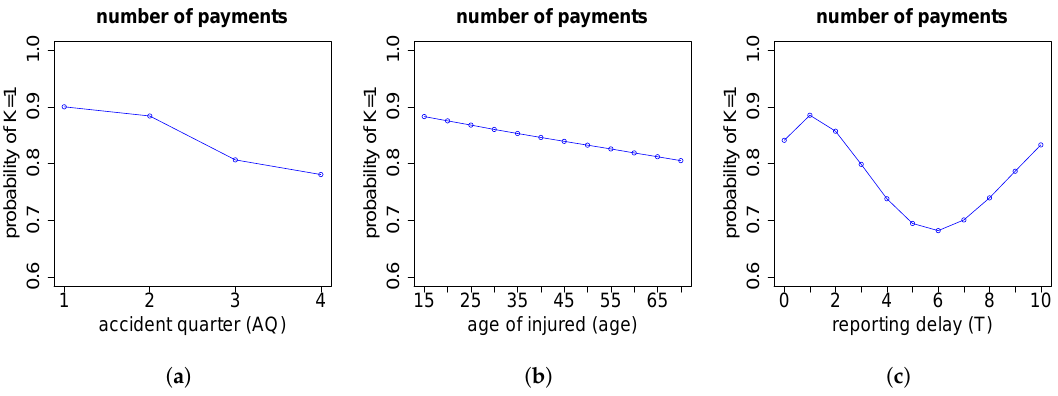
Figure A7. Indicator whether we have K = 1 or K > 1 payments w.r.t. the features ( a ) AQ ; ( b ) age and ( c ) reporting delay T .